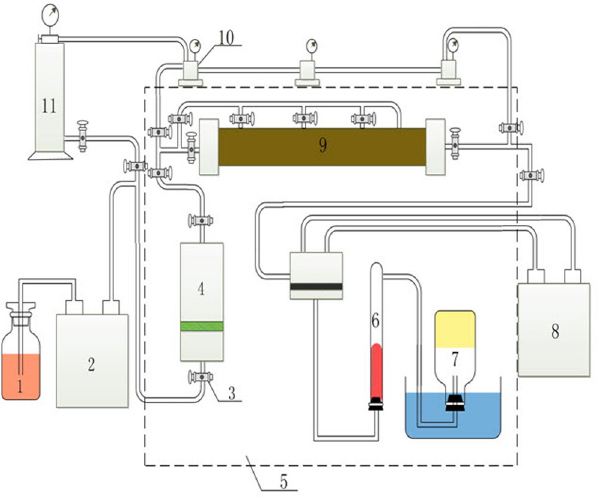
Figure 1. Schematic diagram of the apparatus employed for experimental evaluation of foamy-oil flow. Note: 1-pump working fluid; 2-ISCO pump; 3-valve; 4-sample container; 5-thermostatic system; 6-oil volume gauge; 7-gas volume gauge; 8-back pressure pump; 9-long sand pack; 10-six-port valve; 11-intermediate